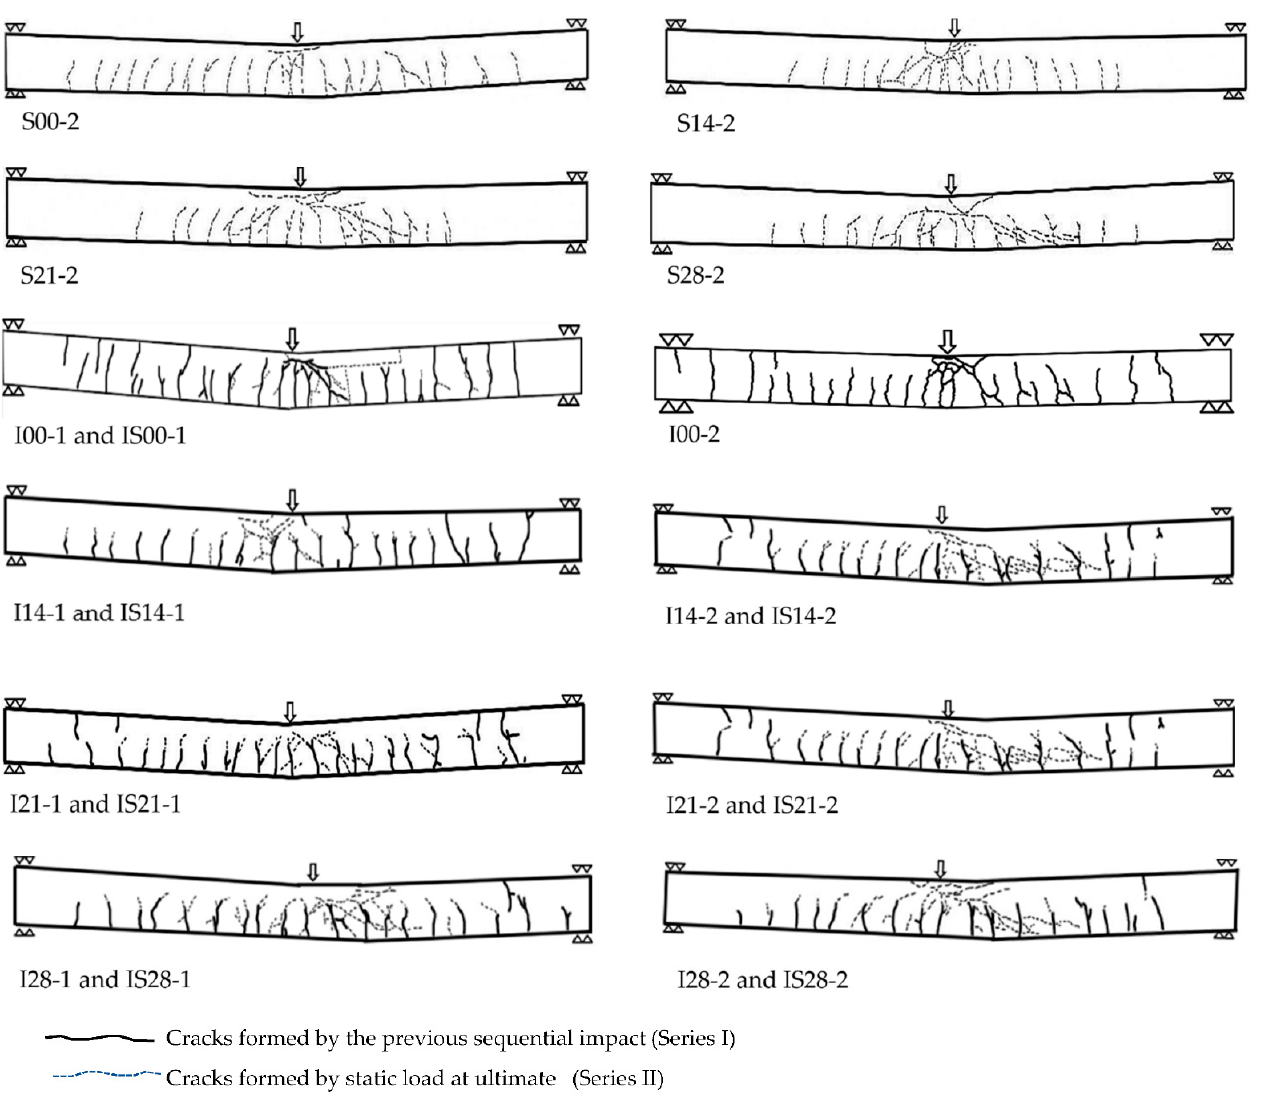
Figure 8. Crack propagation of specimens.